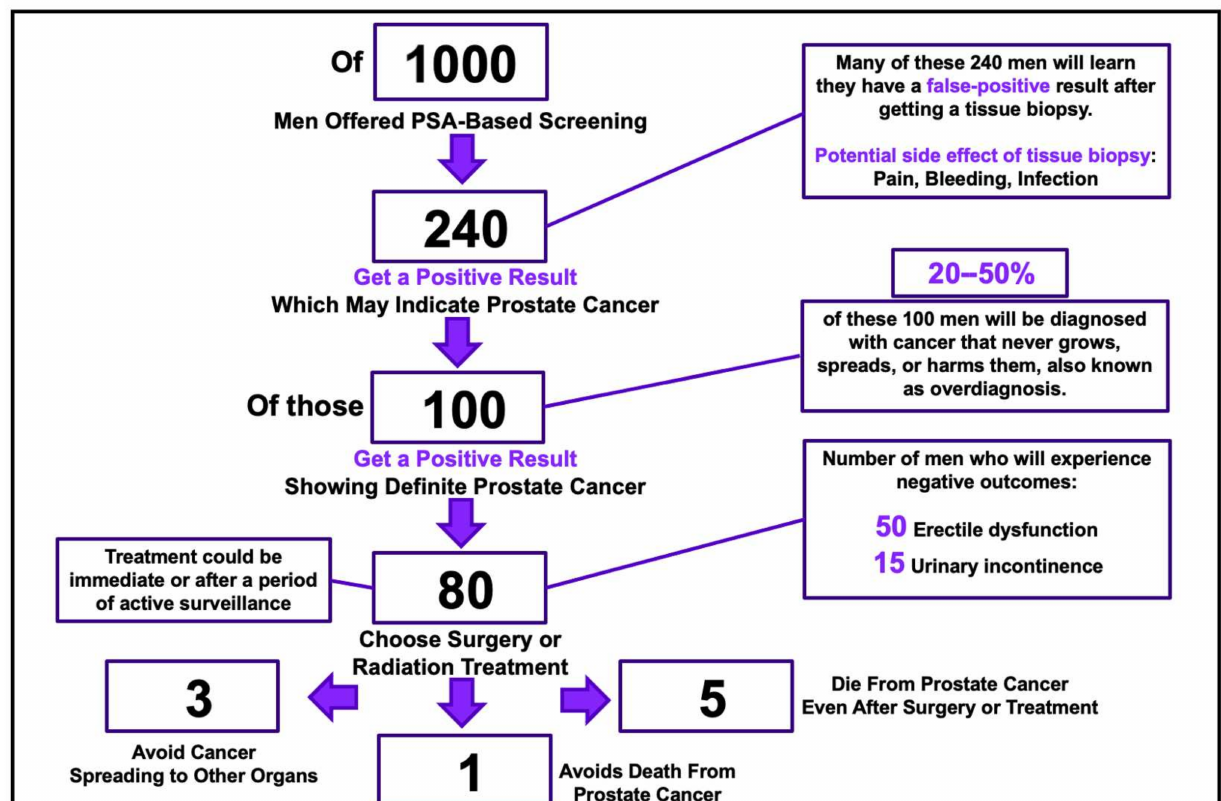
Figure 1. Depicts a schematic published from the USPSTF in 2018, detailing the use of PSA for prostate cancer screening. Figure modified from